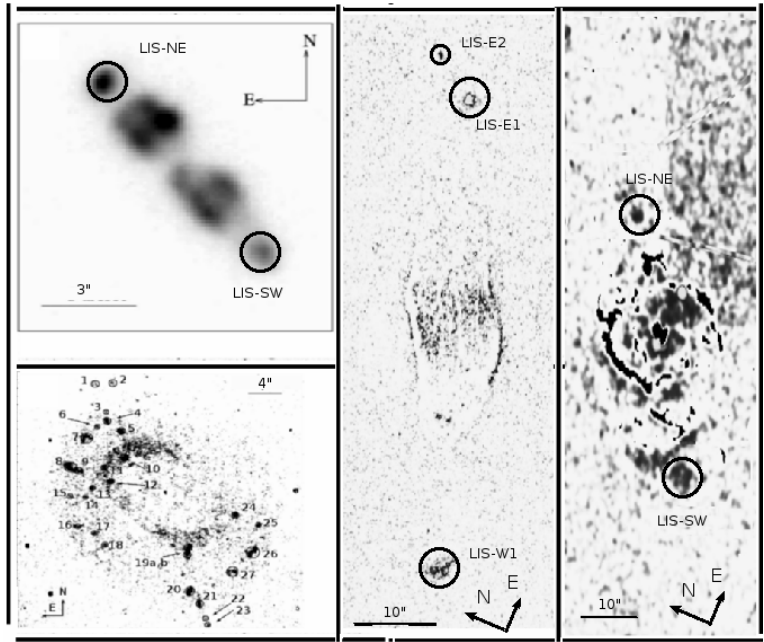
Figure 2. H 2 continuum-subtracted NIRI images of K 4-47 (top-left panel, [16]), NGC 7662 (bottom-left panel, [16]), NGC 7009 (middle panel, [16]) and NGC 6543 (right panel [16]). The circles indicate LIS knots with H 2 emission